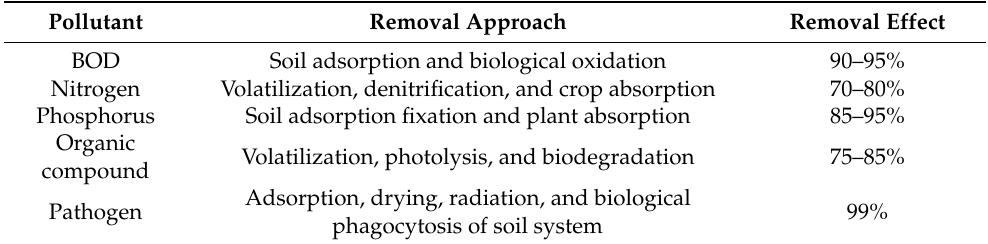
Table 6. Contaminant removal matrix and removal capacity of on-site processing